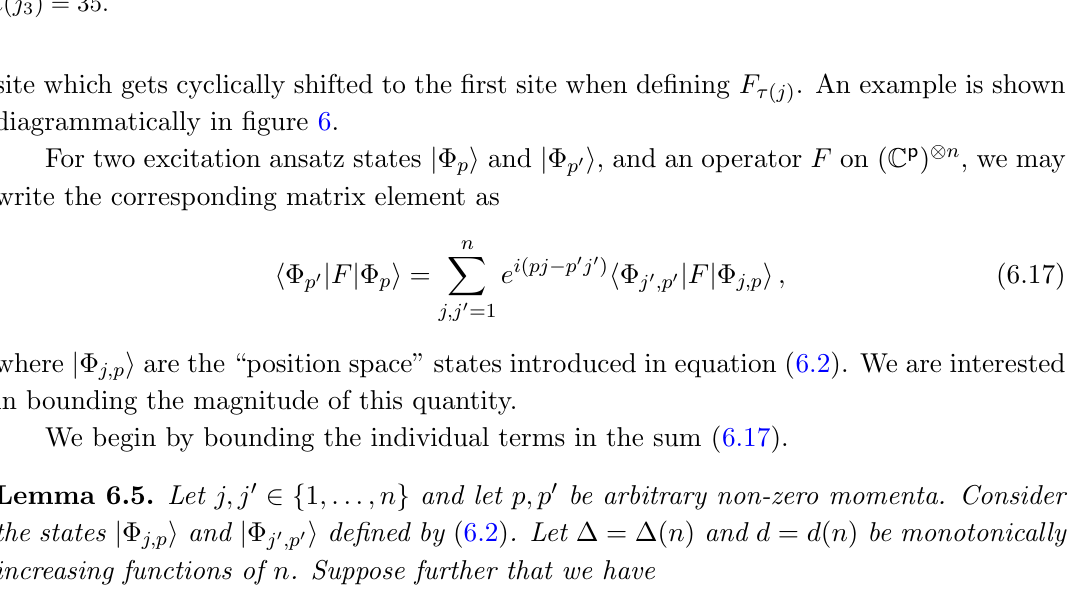
Figure 6 . Example for F and sites j 1 ; j 2 ; j 3 ; j 4 2 f 1 ; : : : ; n g with (cid:19) ( j 1 ) = (cid:19) ( j 4 ) = 7, (cid:19) ( j 2 ) = 19, and (cid:19) ( j 3 ) =